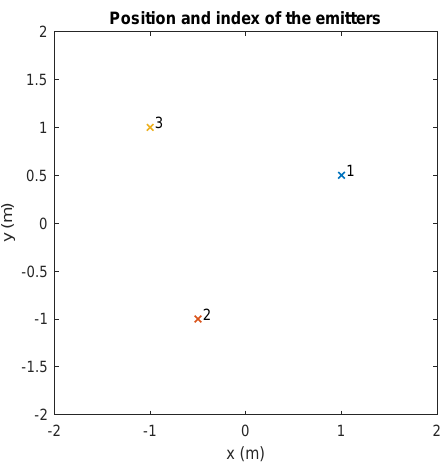
Figure 24. Position and index of different emitters.